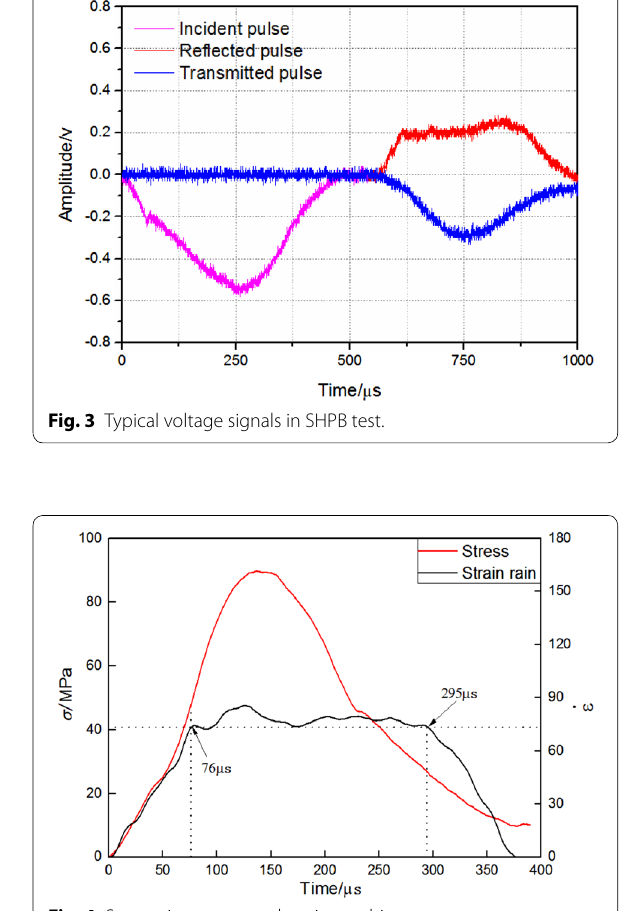
Fig. 4 Stress–time curve and strain rate history